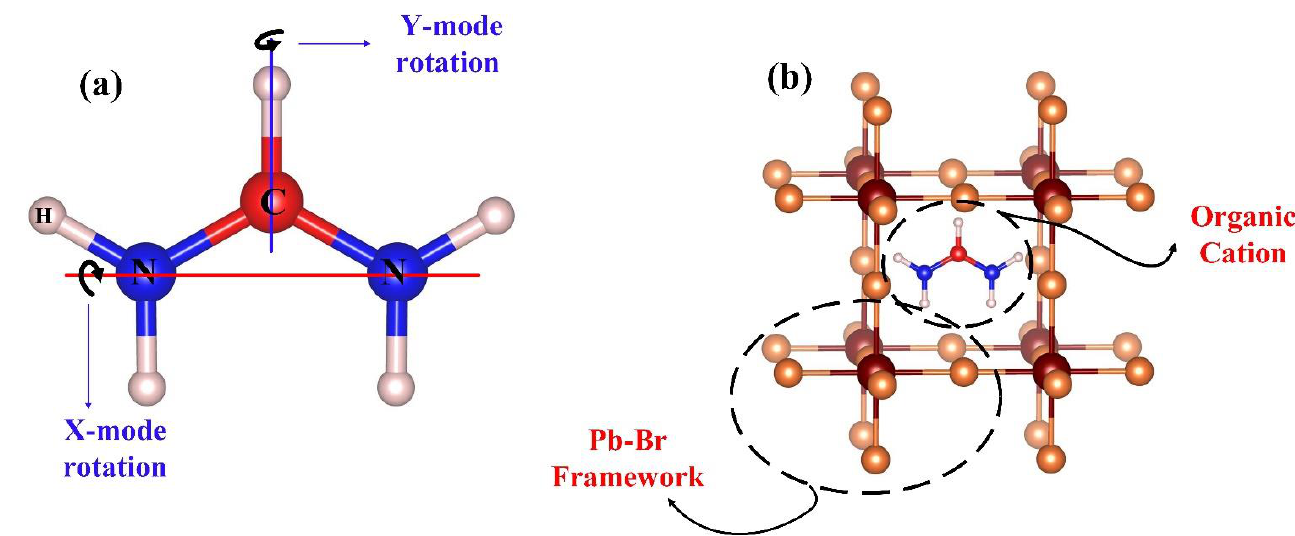
Figure 1. ( a ) Rotational modes of cation FA within the structure of FAPbBr 3 perovskite. ( b ) Position of cation FA and Pb-Br framework within the structure. Table 1 and Figure 2l represent the computed bandgaps for different rotational